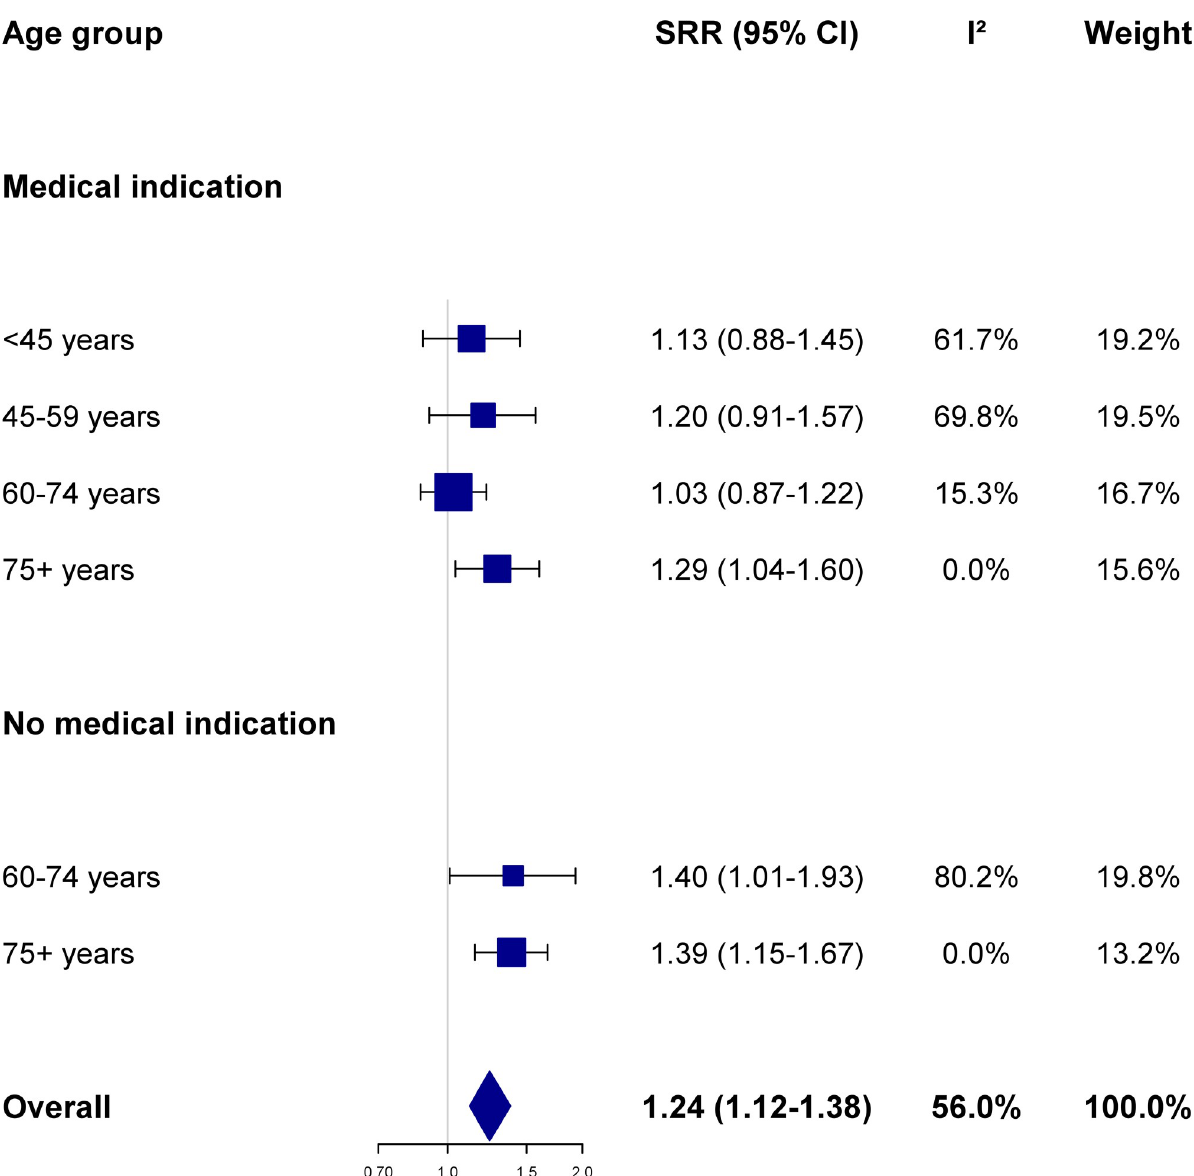
Fig 1. Association between influenza vaccination and the risk of influenza according to age group and presence of medical indication. Summary risk ratio (SRR) and 95% confidence intervals (CI) were calculated by pooling season-specific risk ratio using random effects meta-analysis models; between-seasons heterogeneity was quantified using the I 2 statistics (see text for details; season-specific risk ratio were provided in S1 Table). The Netherlands, seasons 2006/07 to 2015/16.